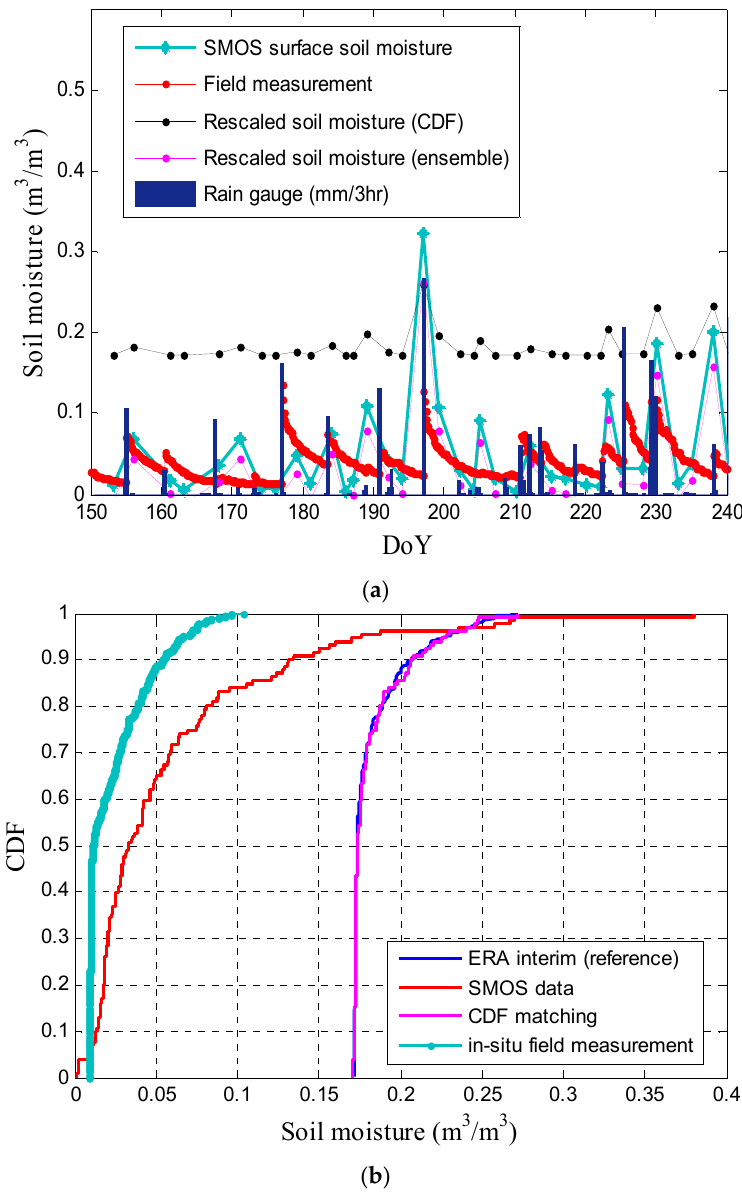
Figure 3. Soil moisture in Niger: ( a ) time-series comparisons; ( b ) cumulative distribution of reference data (ERA interim), SMOS data, CDF matching, and field measurements.